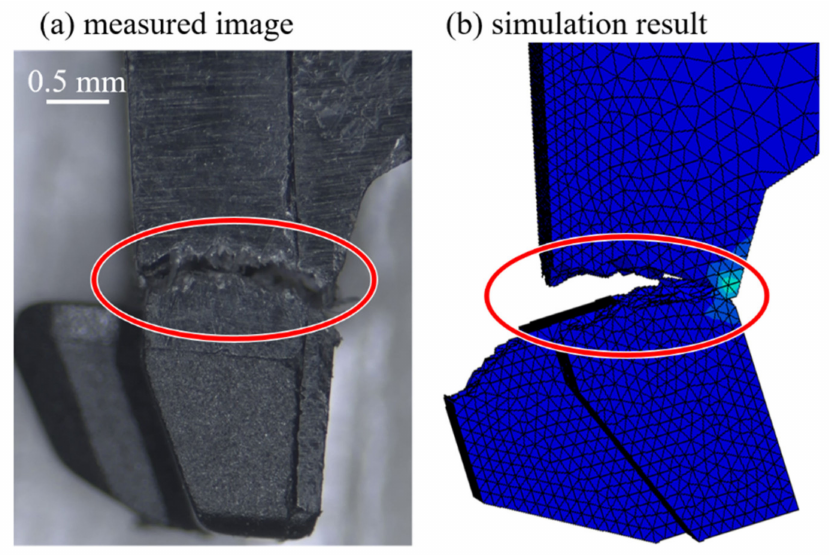
Figure 13. Comparisons of the rupture location based on the experiments and